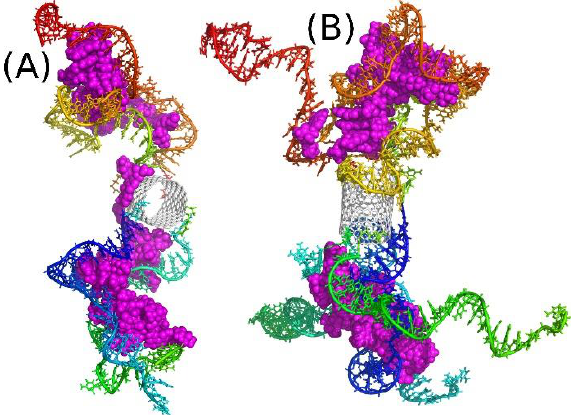
Figure 6. ( A ) The structure of the system I2N after 50 ns of simulations; ( B ) the structure of the system I4N after 50 ns of simulations.